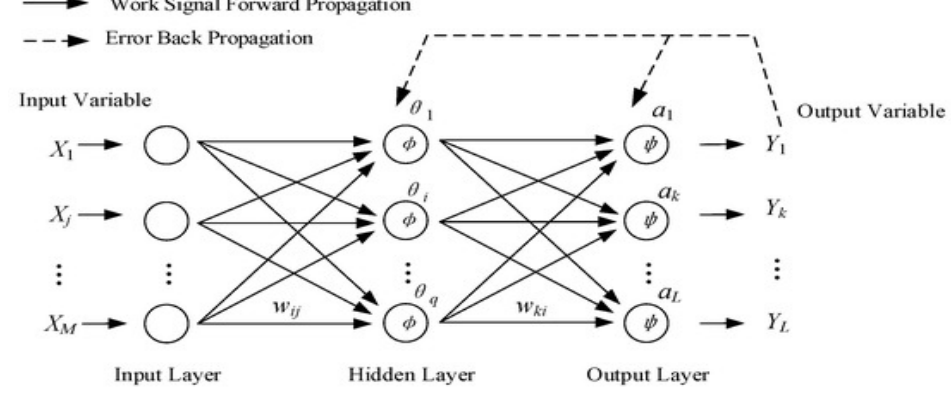
Figure 4. Deep neural network (DNN).